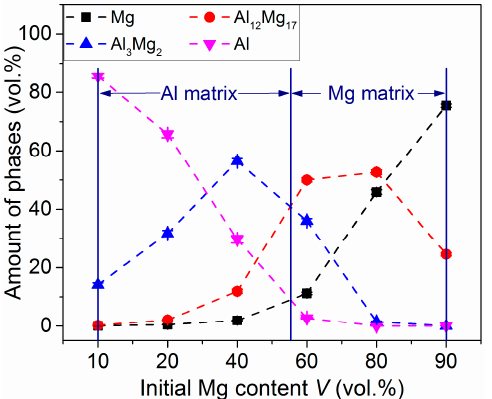
Figure 5. The variation of the amounts of the different phases present in the Al-Mg composites hot-pressed at 673